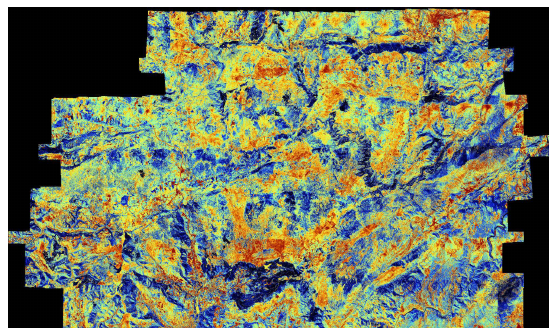
Figure 9c: Our result rendered with Voronoi cells